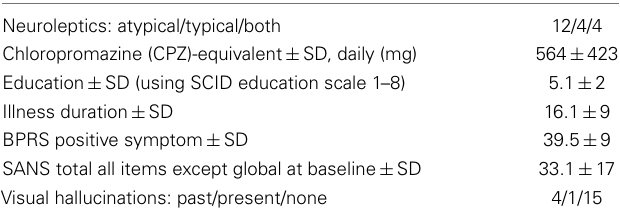
Table 1 | Demographic and clinical characteristics of schizophrenia patient group ( N = 20)